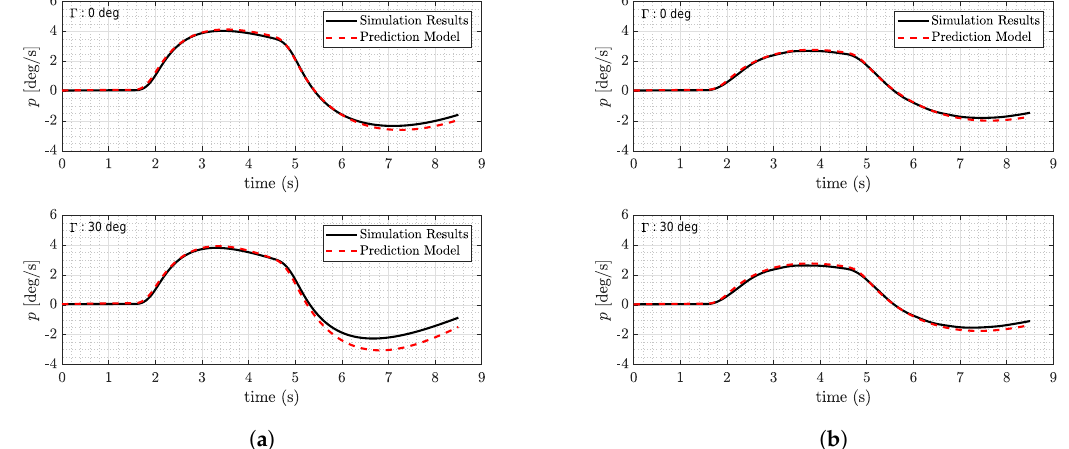
Figure 14. Prediction model and CA 2 LM simulation comparison for a validation of the 20% semispan wingtip device results: ( a ) rgid model 20% wingtip; and ( b ) flexible model 20%